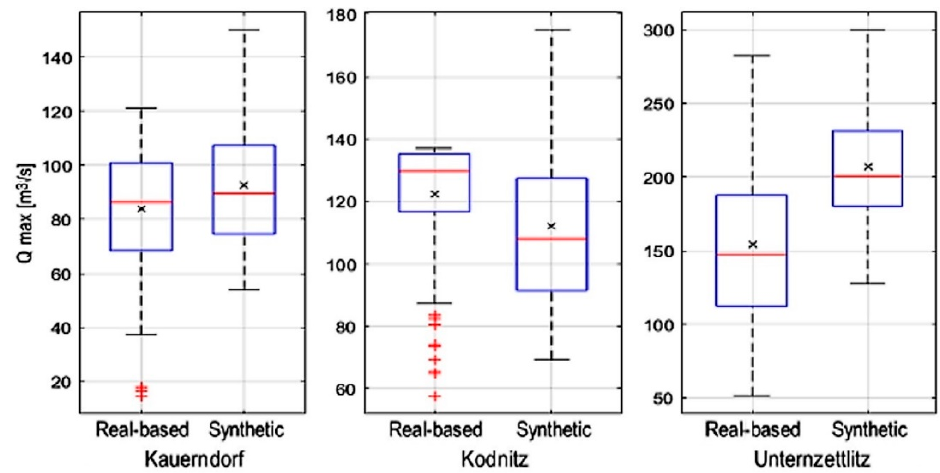
Figure 4. Comparison between the synthetic database and maximum flow rate of the gauges of the three major rivers for the events in the real-event-based database (Taken from [31]).